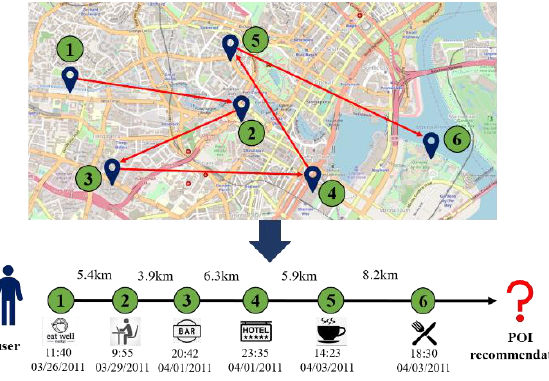
Figure 1. Diagram of a user’s check -in sequence.